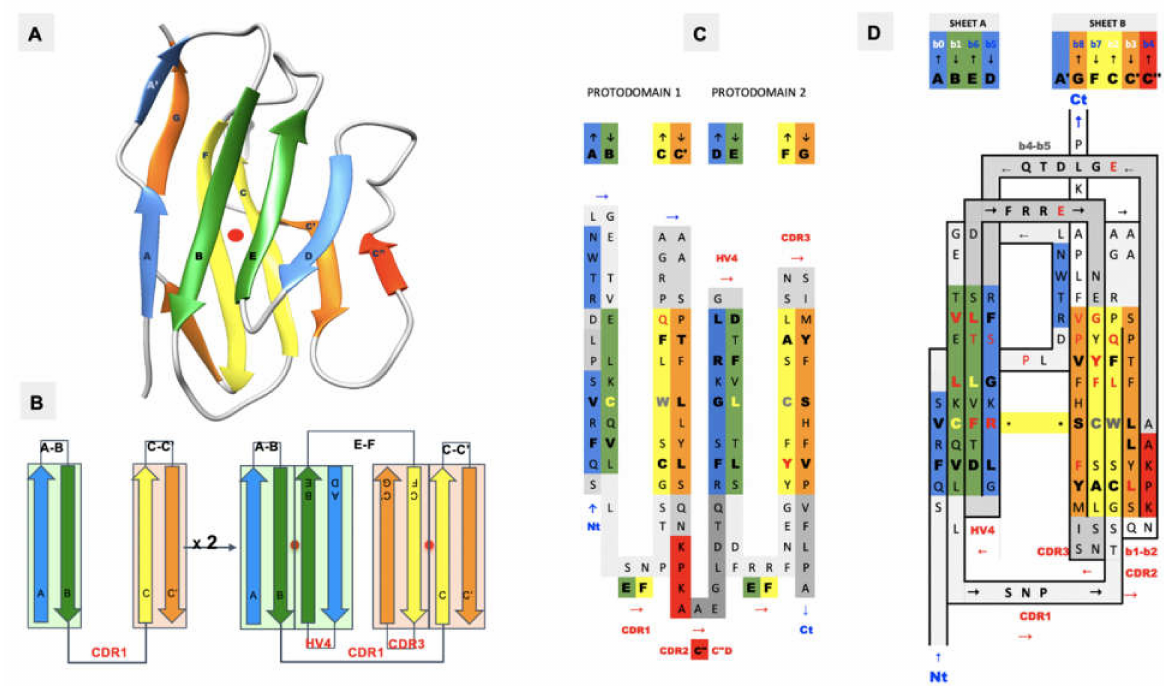
Figure 1. IgV domain deconstruction into pseudosymmetric protodomains with an inverted topology: ( A ) IgV domain—the color scheme blue–green–yellow–orange is associated with each of the individual strands of protodomain 1 A B-C C’ and protodomain 2 D E-F G, which align between 1 and 2A in most IgVs and assemble pseudosymmetrically with a C2 axis of symmetry perpendicular to the paper plane. ( B ) This corresponds to an inverted topology (using a membrane protein nomenclature) between the two protodomains. ( C ) They invert through the linker [CDR2-C” strand-C”D loop]. ( D ) The resulting IgV topology shows the self-complementary assembly of the protodomains through their central strands, the B|E and C|F strands. Symmetry breaking occurs through the C” and A’ strands. In IgVs, unlike IgCs, the A strand splits in two through a proline or a number of glycine residues and participates to the two sheets A B E D and A’|G F C C’|C”. In figure ( A ), we use PDBid 2ATP, where the A’ strand is well formed. In ( D ), the sequence/topology map for the CD8 sequence. iCn3D link for CD8 (https://structure.ncbi.nlm.nih.gov/icn3d/share.html?JcP3sd1gGfqXEBEM8, accessed on 27 August 2021) (PDBid 1CD8) is